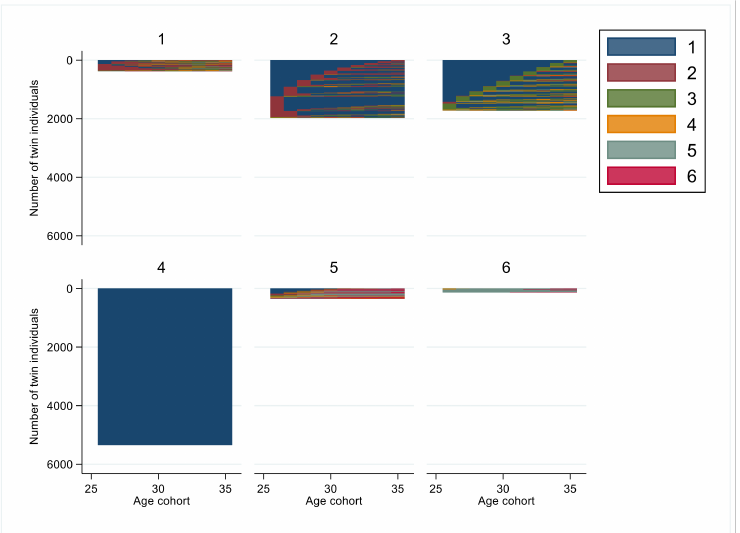
Figure 1. Cluster groups of sequences of interruptions in the working life among the age cohort 26–35 years (Code for colors: 1. sustainable working life : SA/DP 0–30 days and UE 0–90 days;